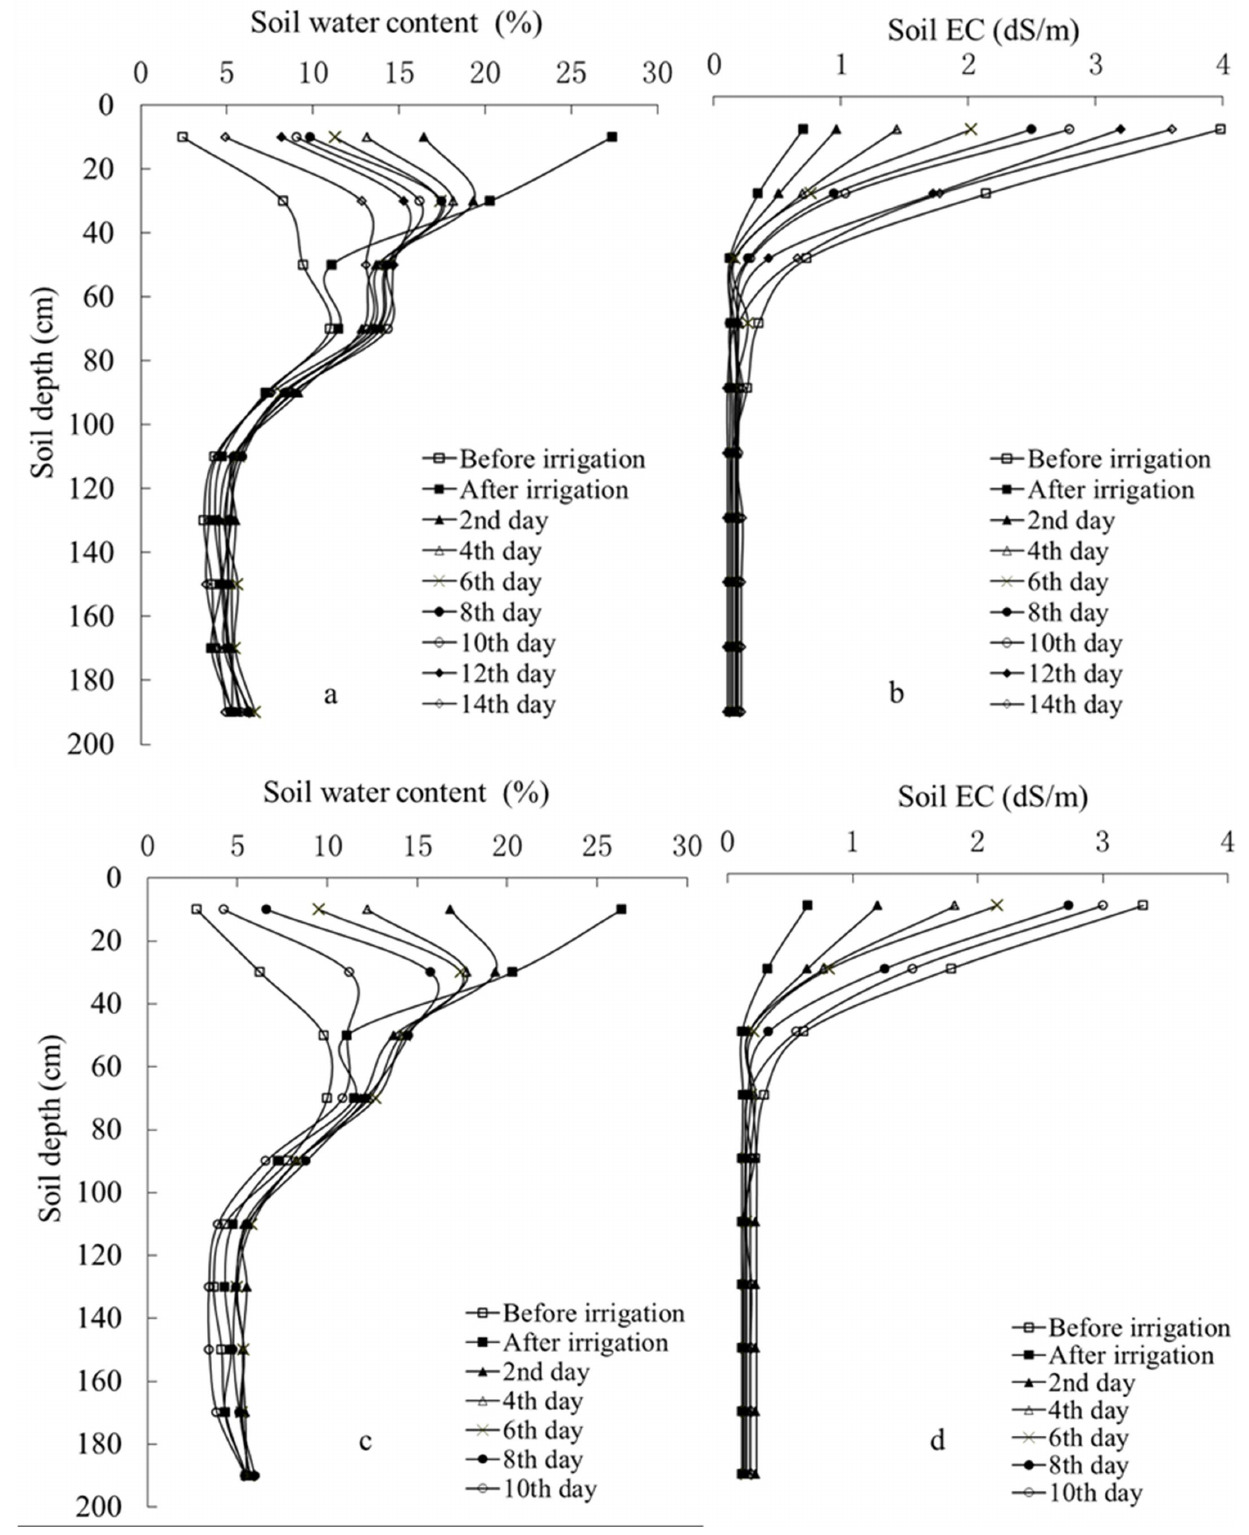
Fig 4. Dynamicsof soil moisture and salinity within an irrigation cycle. (a,b) Soil moisture and salinity of 15-day-cycle for Tamarix ramosissima and Haloxylonammodendron ; (c,d) Soil moisture and salinity of 10-day-cycle for Calligonumarborescens . doi:10.1371/journal.pone.0164106.g004 PLOS ONE | DOI:10.1371/journal.pone.0164106 October 6,